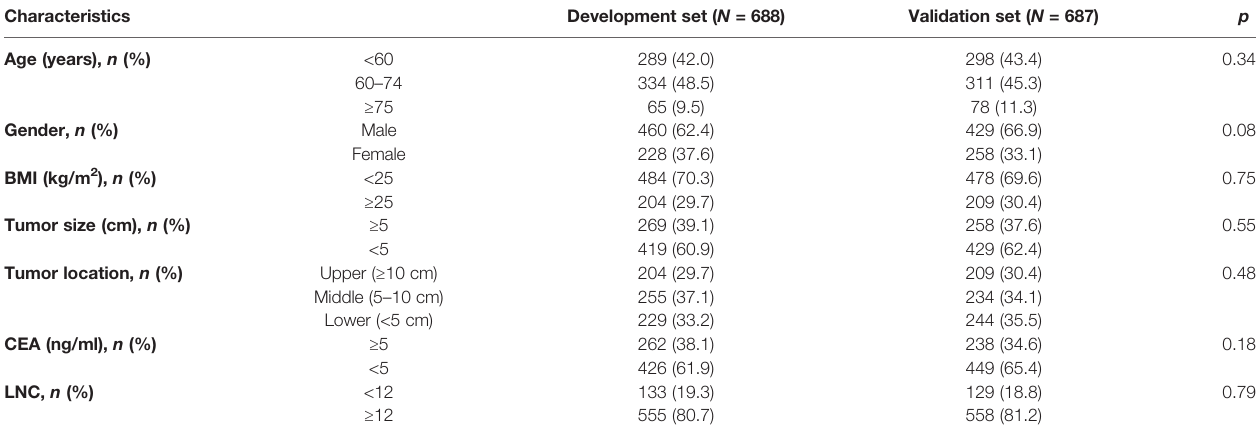
TABLE 1 | Characteristics of patients in the development and validation sets.